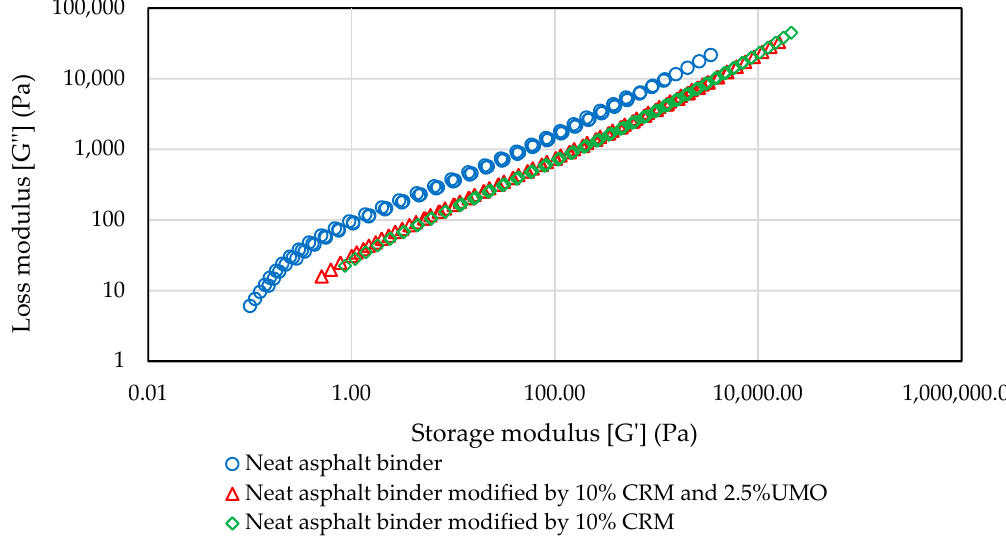
Figure 10. Cole-Cole diagram for PG 64-22 neat and modified asphalt binders interacted at 190 ◦ C—50 Hz—62 min, measured at a reference temperature 60 ◦ C.